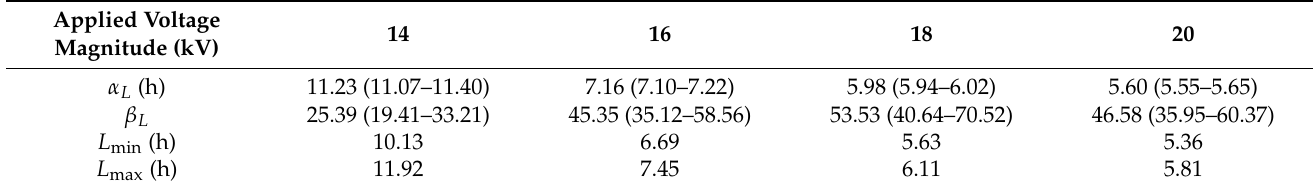
Table 5. Parameters of the Weibull function fitted to the life estimations from simulation results at each applied voltage magnitude and their maximum and minimum